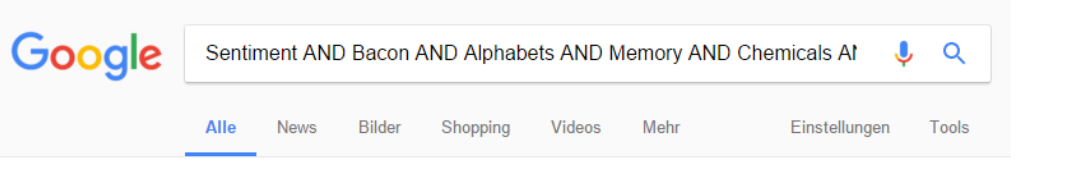
Figure 3. Hits counts for a conjunctive query of length 10.